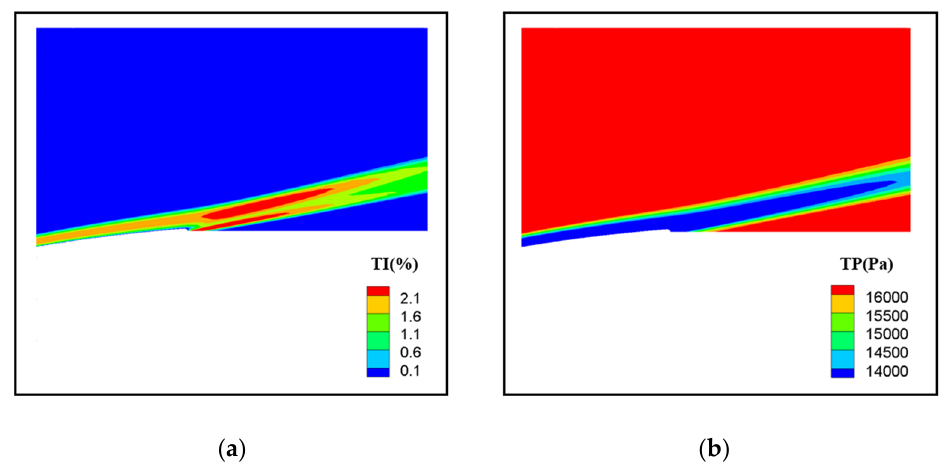
Figure 15. Turbulence intensity and total pressure contours near the section surface. ( a ) Turbulence intensity; ( b ) total pressure.